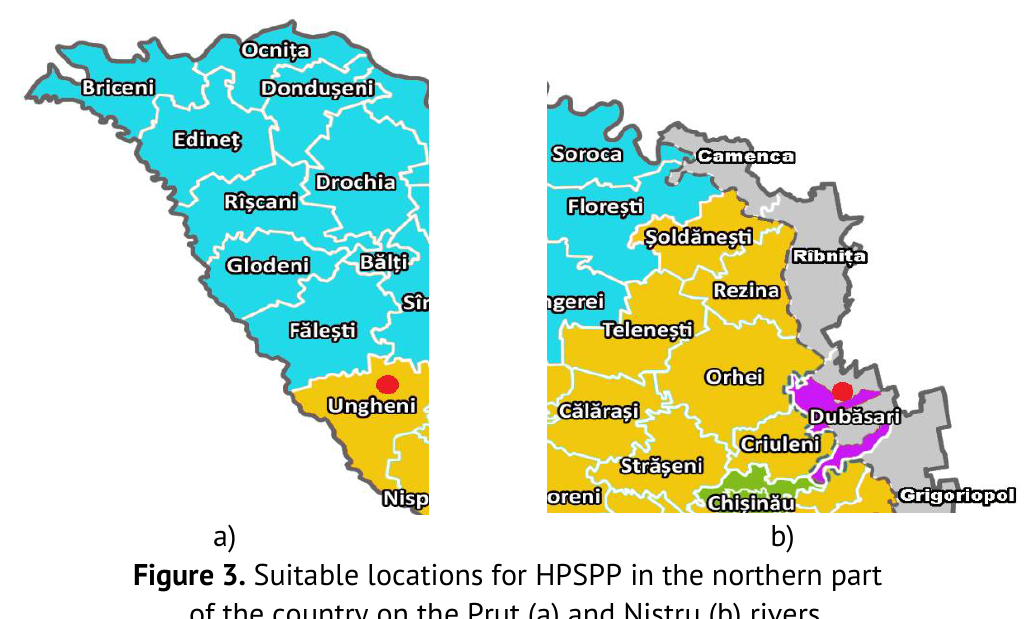
Figure 3. Suitable locations for HPSPP in the northern part of the country on the Prut (a) and Nistru (b)